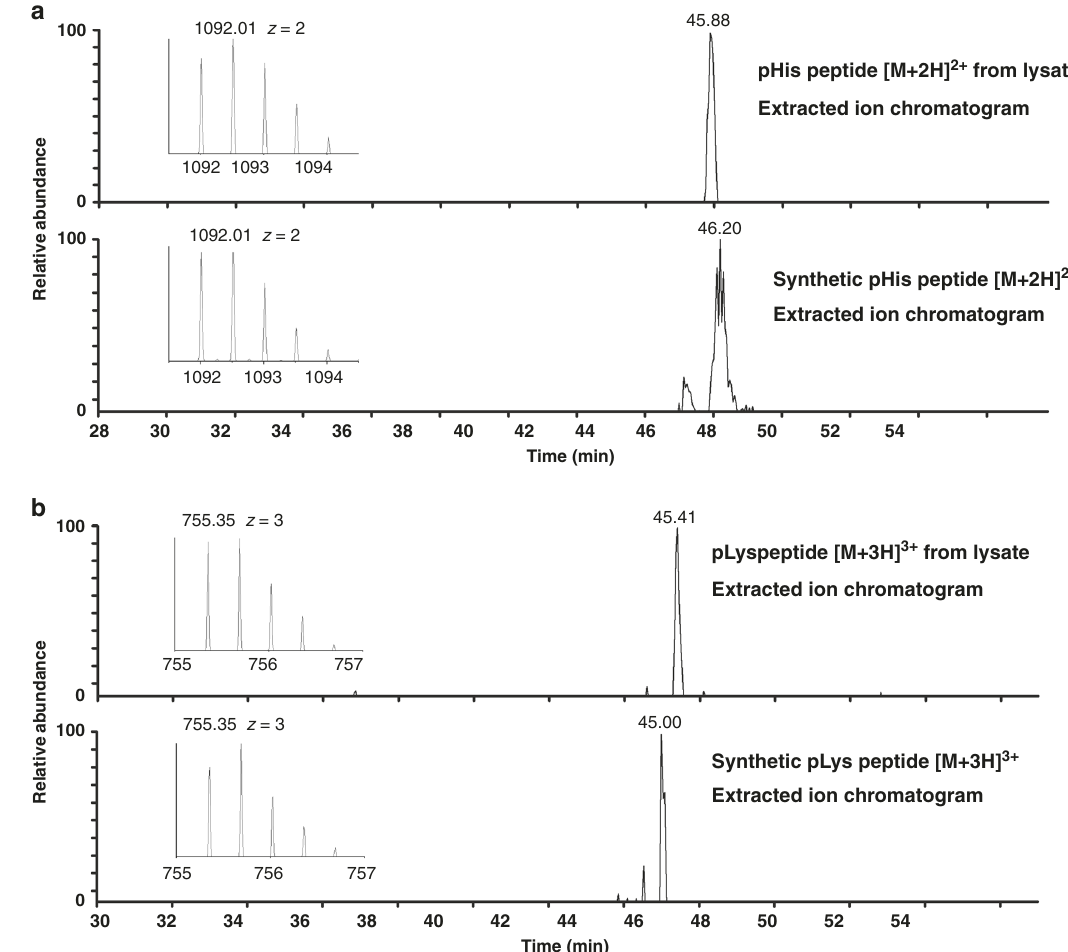
Fig. 5 HPLC validation of Y fi D pHis and pLys peptides in E. coli . Extracted ion chromatogram of a the pHis peptide and b pLys peptide from E. coli lysates (top) and synthetic peptide (bottom), respectively. Insets are the MS spectra of the precursor species at m / z 1092.01 and 755.35. These graphs are made with origin